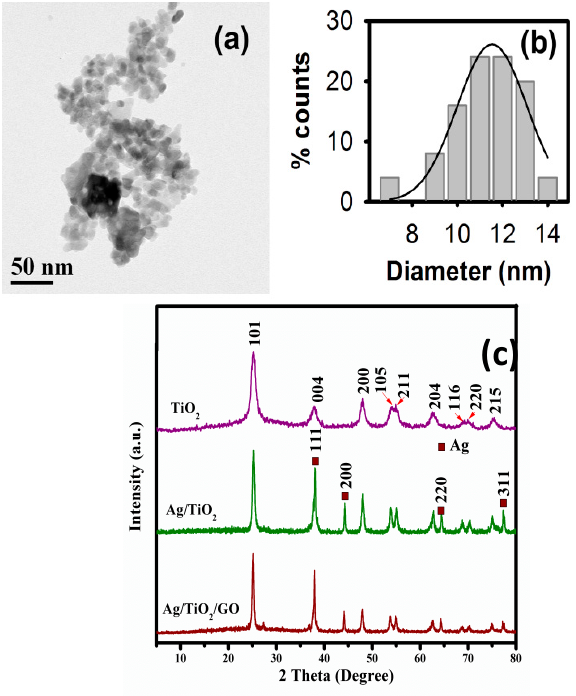
Figure 2. ( a ) TEM micrograph and ( b ) size distribution of TiO 2 NPs prepared using microwave radiation. ( c ) The XRD pattern of the TiO 2 , Ag/TiO 2 , and Ag/TiO 2 /GO nanocomposites showing the crystal planes of the anatase form confirmed from JCPDS 01-075-2550.